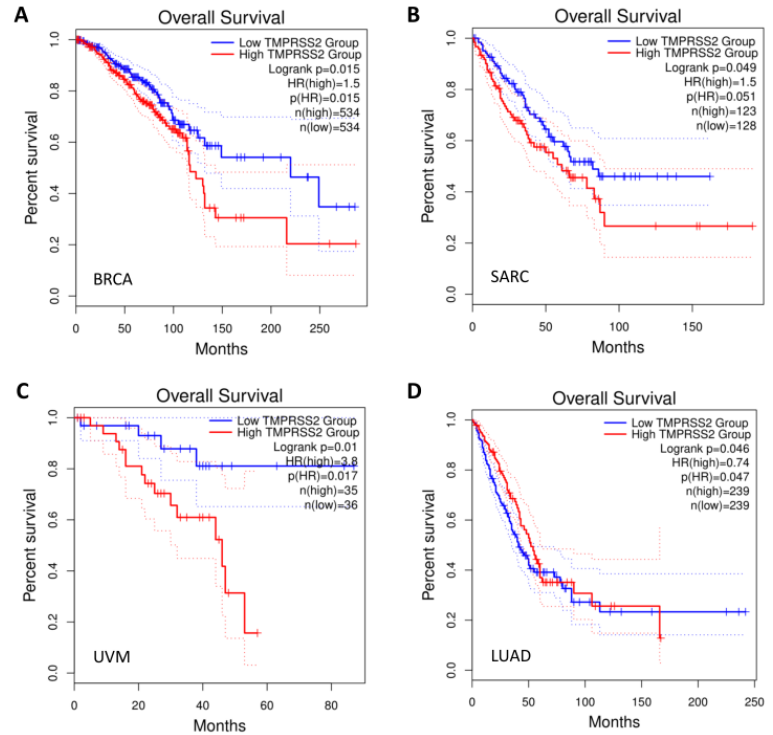
Figure 2. Overall survival of cancer patients according to TMPRSS2 expression. ( A ) BRCA. ( B ) SARC. ( C ) UVM. ( D ) LUAD. BRCA: breast invasive carcinoma; SARC: sarcoma; UVM: uveal melanoma; LUAD: lung